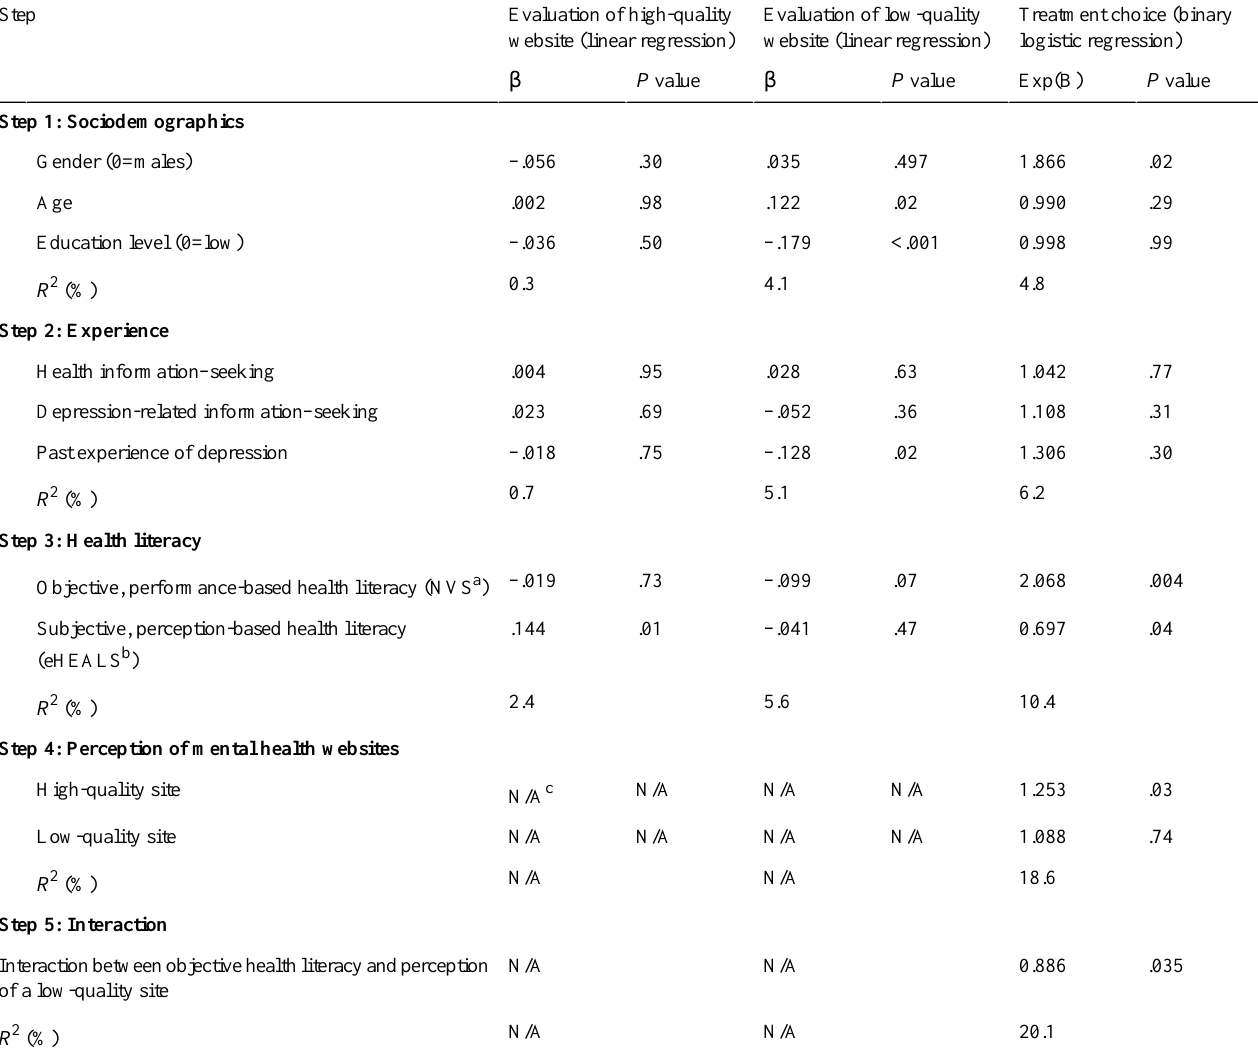
Table 2. Regression analyses for predicting the perception of high- and low-quality mental health websites and treatment choice.